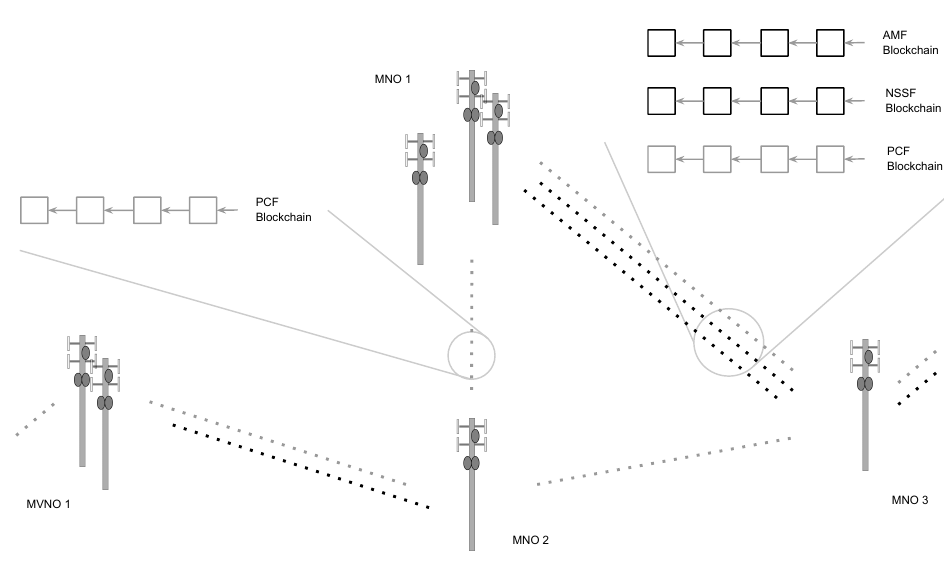
Figure 4. Example of multiple network function-specific blockchains running across